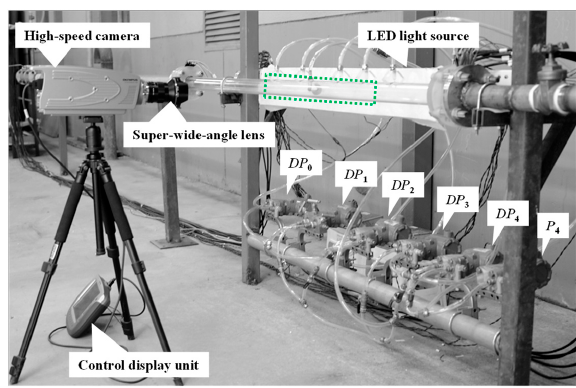
Figure 2. Photos of the measurement sensors.